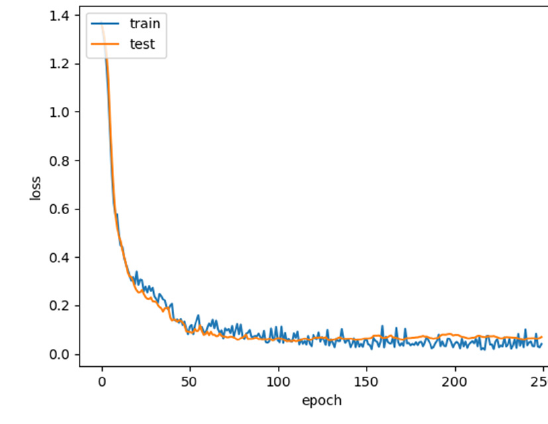
Figure 7. Accuracy and loss for boys’ physical fitness level evaluation. ( a , b ) Accuracy and loss when epoch is 250; ( c , d ) Accuracy and loss when epoch is 300; ( e , f ) Accuracy and loss when epoch is 350.